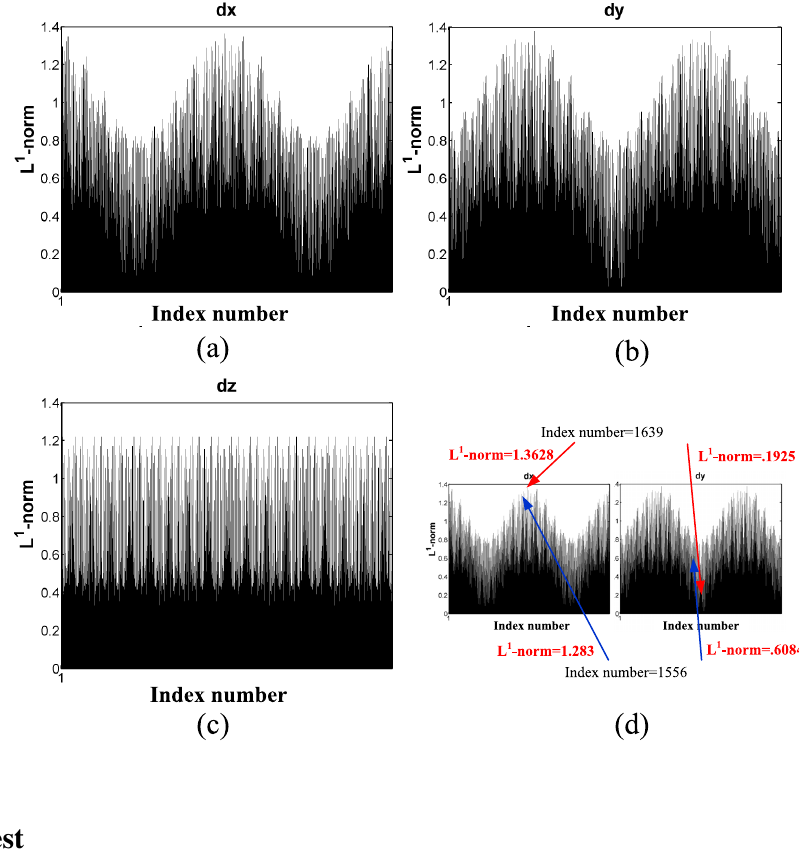
Figure 14. Cartesian position errors with respect to index number. Joint resolution is 20 degrees. ( a ) d ; ( b ) d ; ( c ) d ; ( d ) the same index number (joint positions) results in x y z different L 1 -norm values on d and d x y